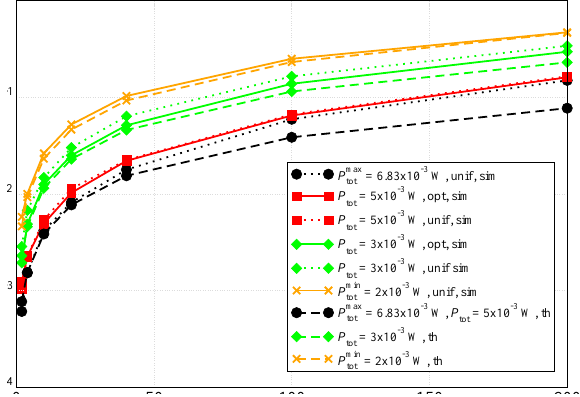
Figure 12. PER as a function of the aggregated offered traffic load Ng . Different transmit power allocation strategies are considered for the topology with N = 20 nodes presented in Figure 3b: (i) fixed per-node transmit power (unif) and (ii) optimized transmit power (opt). Both simulation (solid lines) and analytical (dashed lines) results are presented. The dotted lines refer to scenarios where no optimized power allocation strategy is used.